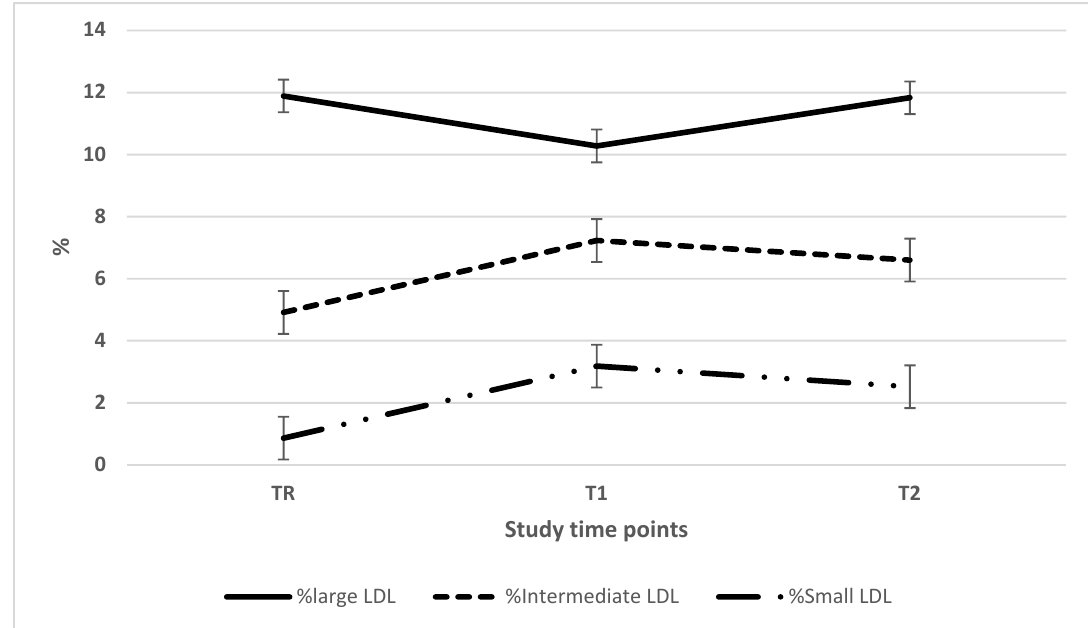
Figure 3. LDL particle size distributions. The percentage of LDL particle size (large, intermediate and small) distributions during the study period. Abbreviations: LDL: low-density lipoprotein; TR: during Ramadan; T1: one month post-Ramadan; T2: two months post-Ramadan. There is a significant di ff erence for large LDL between TR and T1, and T2 and T1, also, for i- LDL and s-LDL between TR and T1 and between TR and T1 at p < 0.5